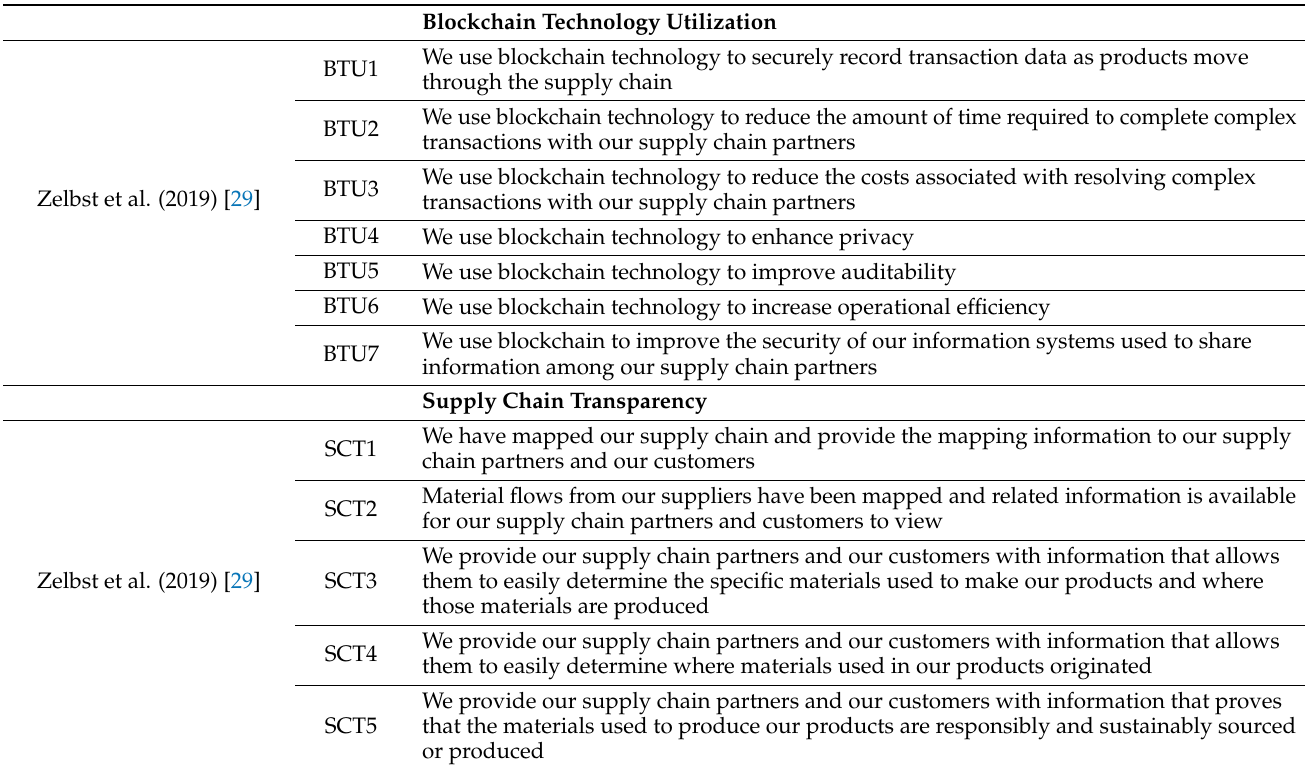
Table A1. Measurement